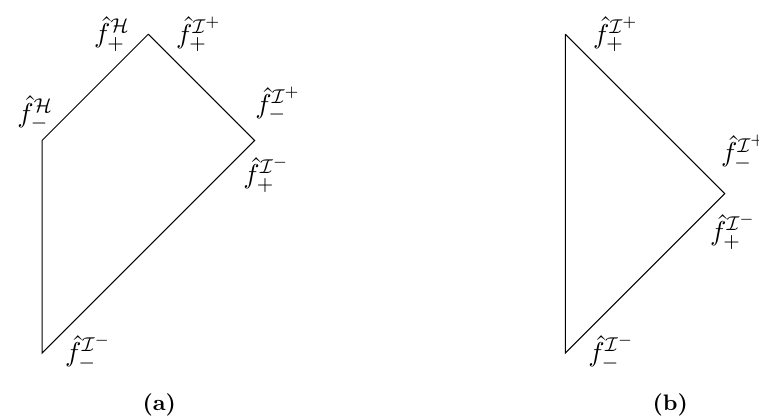
Figure 11. Soft boundary modes associated with the null components of our in and out Cauchy slices for the gravitational collapse geometry (left) and for flat Minkowski space